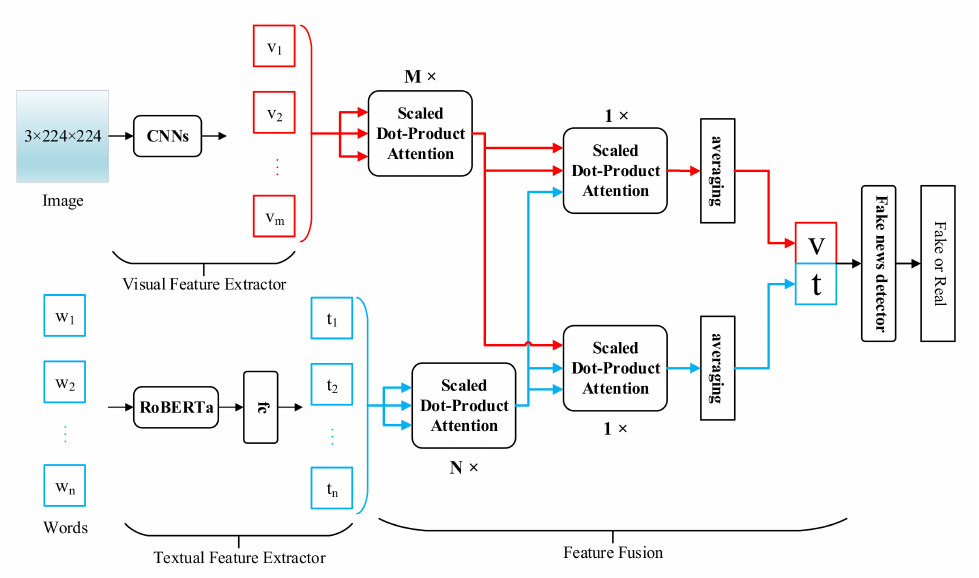
Figure 1. The architecture of our FMFN